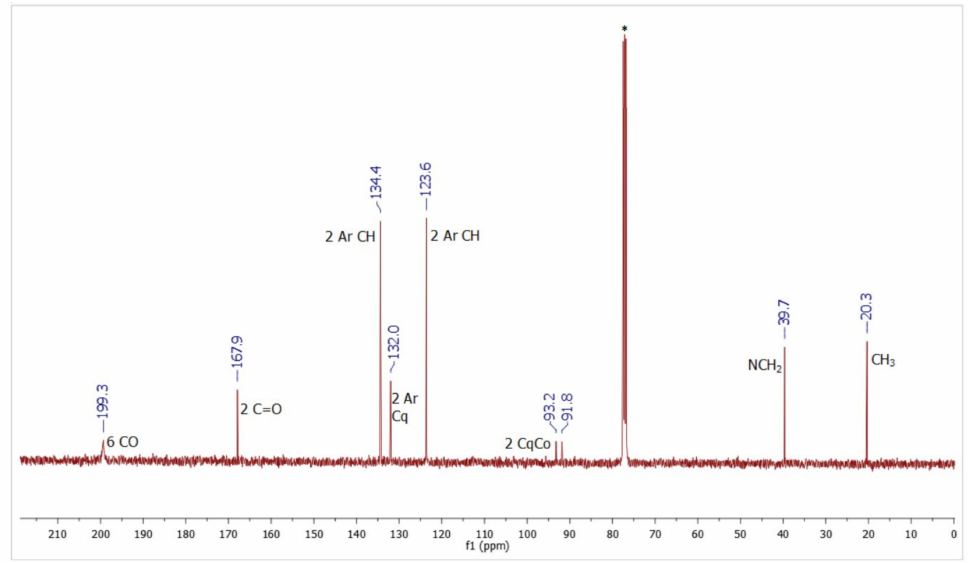
Figure 3. 13 C{ 1 H}-NMR spectrum (100.62 MHz, CDCl 3 ) of compound 2 at 25 ◦ C. The asterisk * denotes the CDCl 3 resonance.